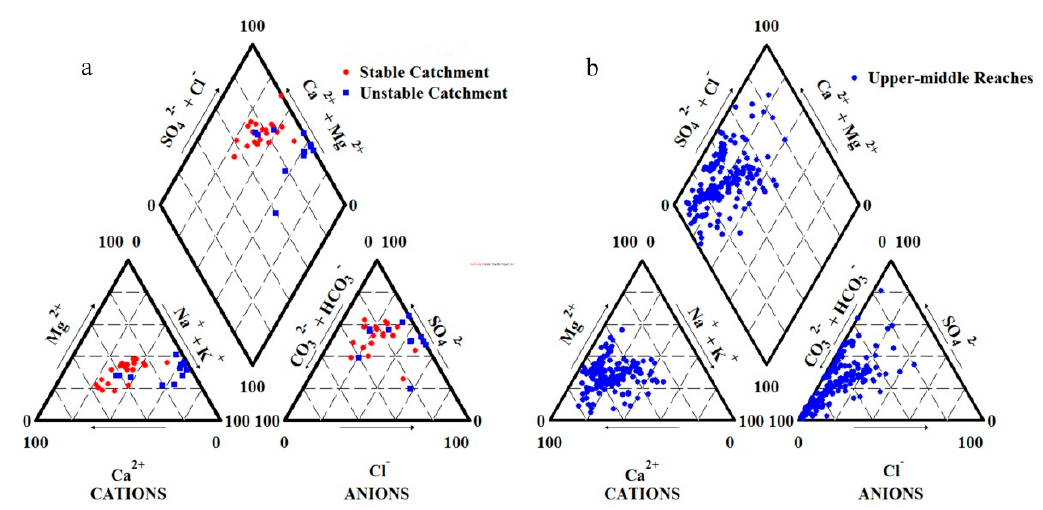
Figure 2. Piper diagram of main ions composition of Qingtu Lake ( a ) and upper-middle reaches of the Shiyang River Basin ( b ).